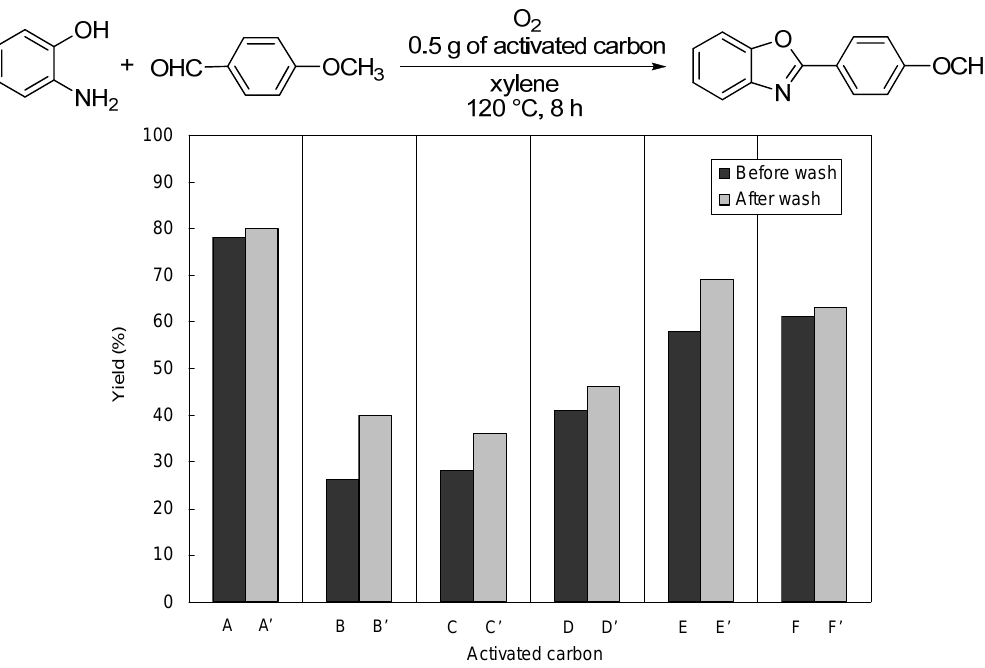
Figure 2. Reaction yields using washed and unwashed activated